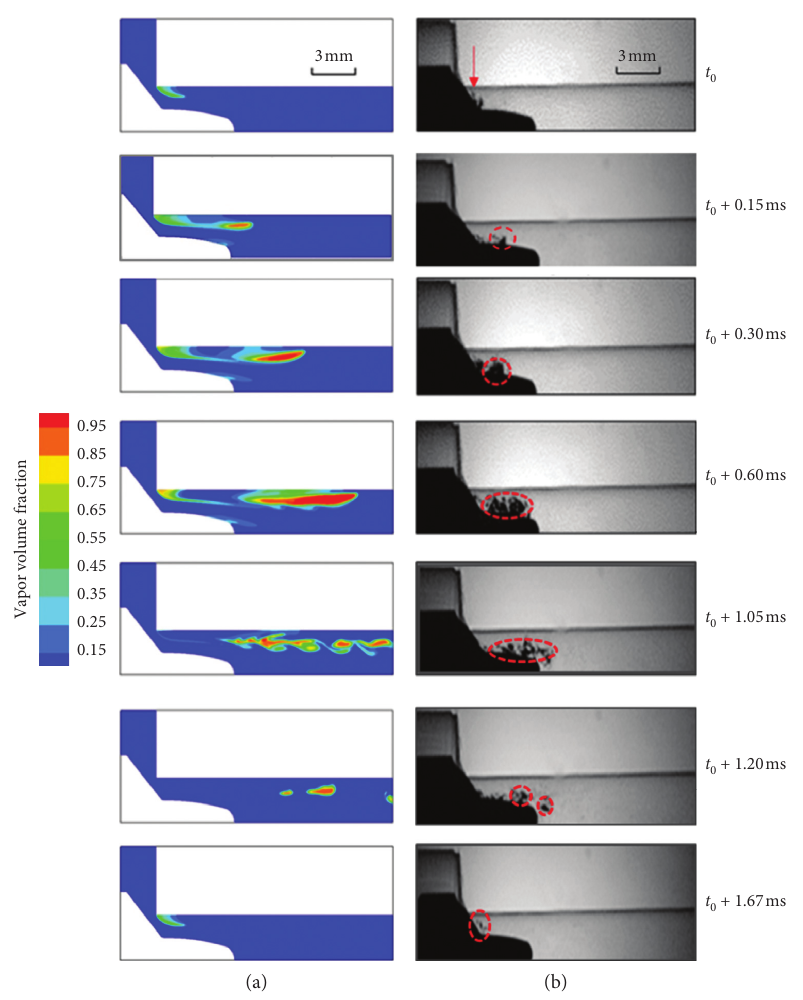
Figure 3: Typical evolution process of cavitation bubble.